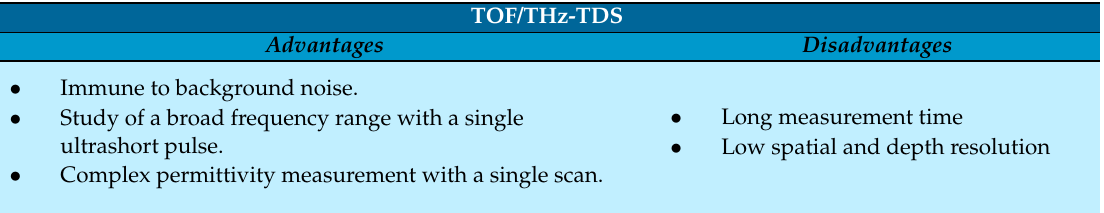
Table 13. Advantages and disadvantages of TOF and THz-TDS.